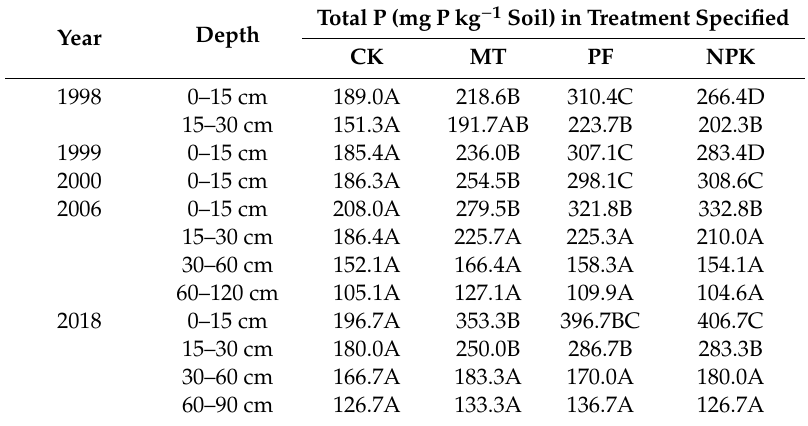
Table 3. Total P concentration in soils at depth, treatment, and year specified.